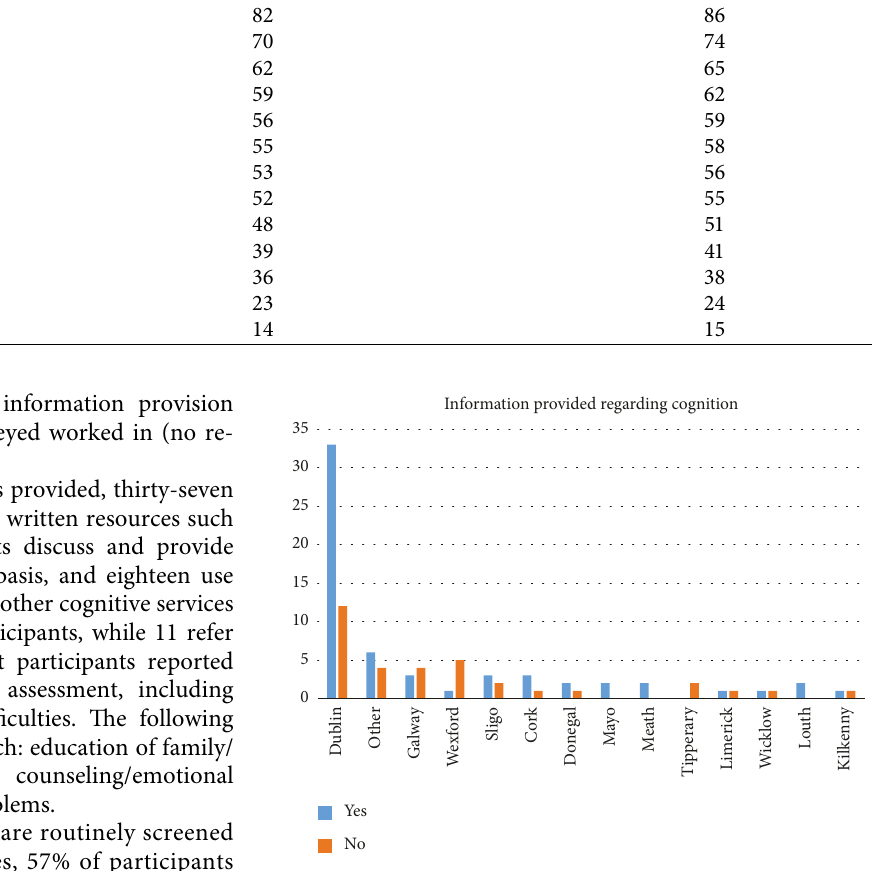
Figure 2: Services providing information regarding cognition according to HCPs